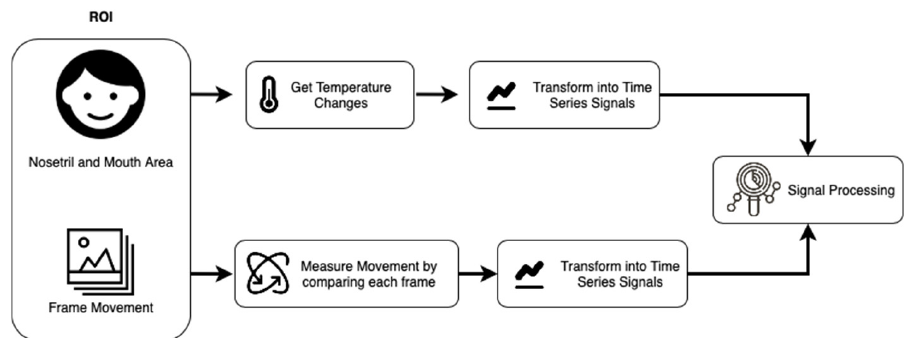
Figure 3. An overview of how the signal extraction process from a thermal image is carried out. In general, there are two methods: first by measuring changes in temperature in the area around the nostrils and mouth, and second by looking at the movement based on the comparison between changes in pixels in each